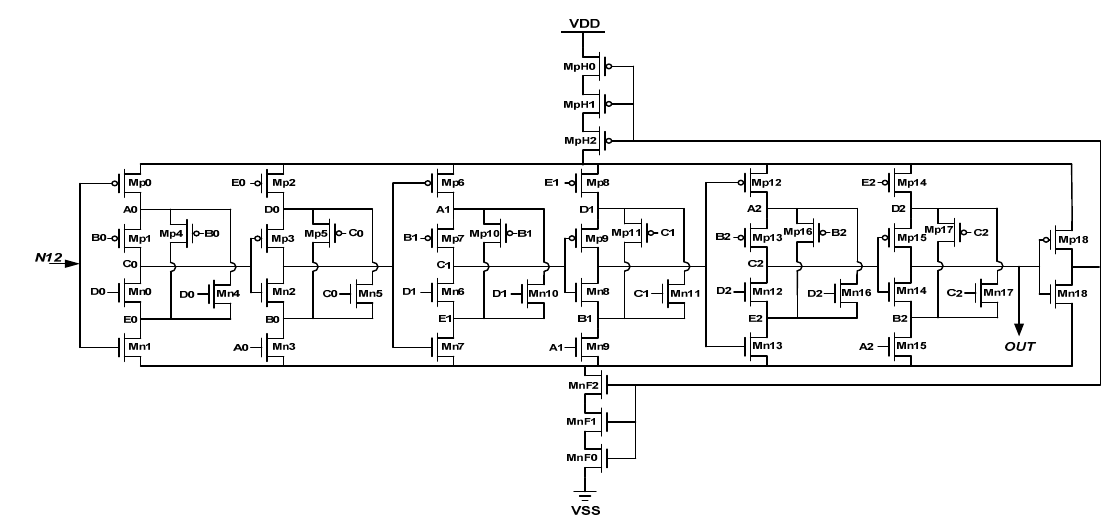
Figure 5. The circuit diagrams of the long hysteresis delay cell (LHDC).